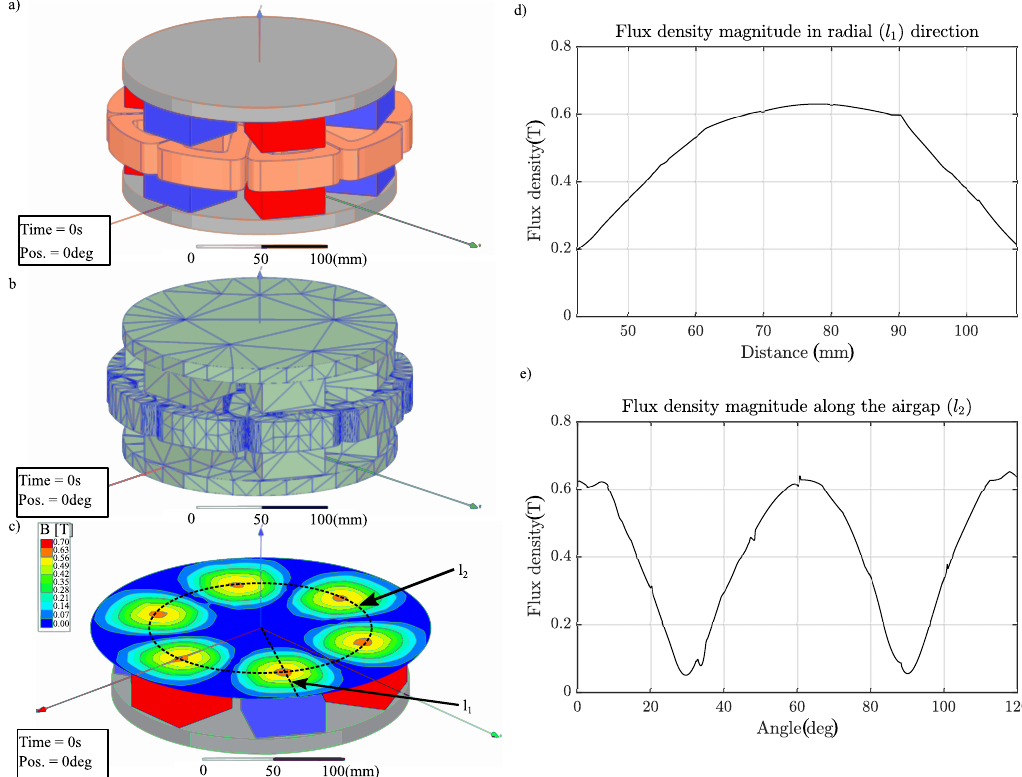
Figure 7. FEM analysis of designed machine: ( a ) geometry view in Ansys Maxwell 3D, ( b ) finite elements discretisation of the geometry, ( c ) example of the results—flux density in the middle of the coreless armature, ( d ) flux density in the radial direction (along l 1 ), ( e ) flux density along the air gap at the middle of PM (along l 2